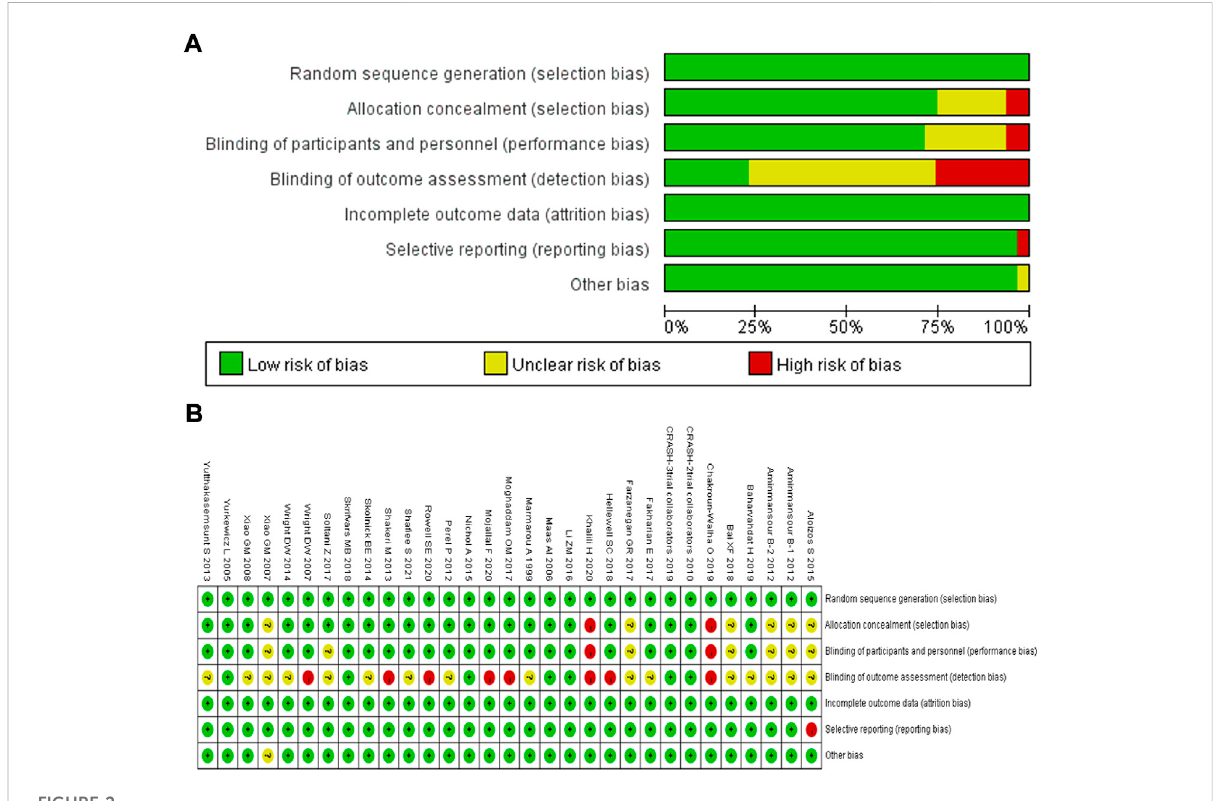
FIGURE 2 Qualityassessmentofidenti fi edrandomizedcontrolled trials; (A) Eachriskofbiasitempresented aspercentages acrossallincludedstudies; (B) Eachriskofbiasitemforeachincludedstudy.Greenindicatesalowriskofbias,yellowindicatesanunclearriskofbias,andredindicatesahighriskof